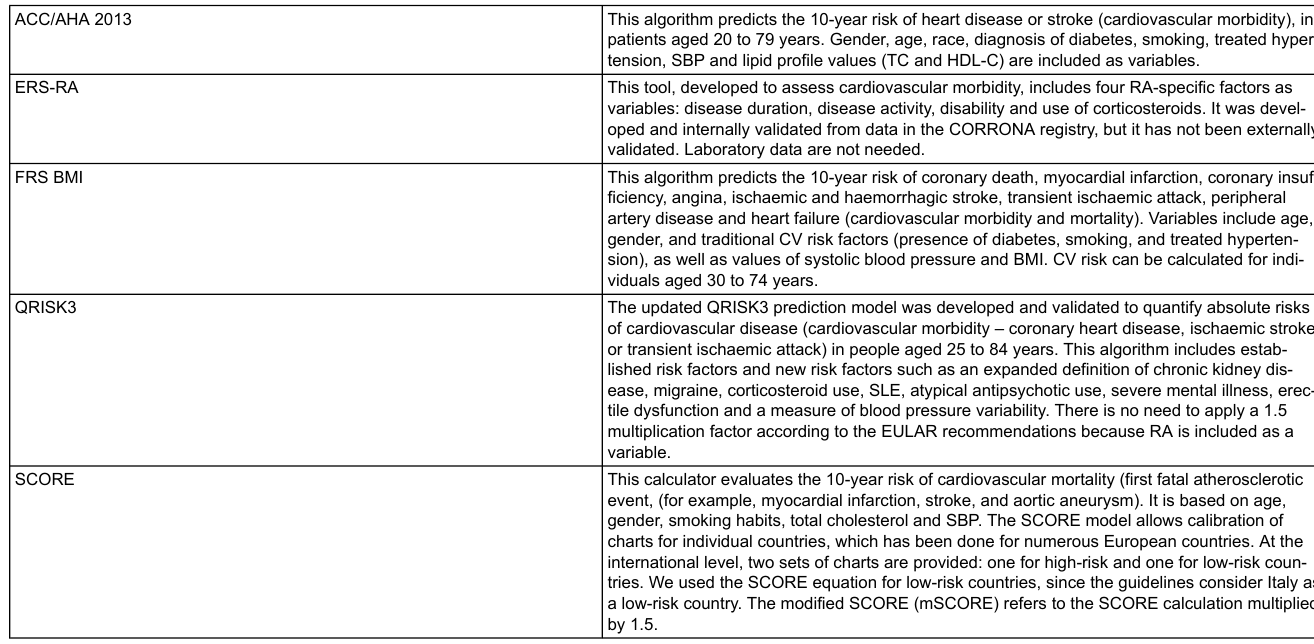
Table 1: Characteristics of the cardiovascular risk prediction scores. ACC/AHA 2013 This algorithm predicts the 10-year risk of heart disease or stroke (cardiovascular morbidity), in patients aged 20 to 79 years. Gender, age, race, diagnosis of diabetes, smoking, treated hyper- tension, SBP and lipid profile values (TC and HDL-C) are included as